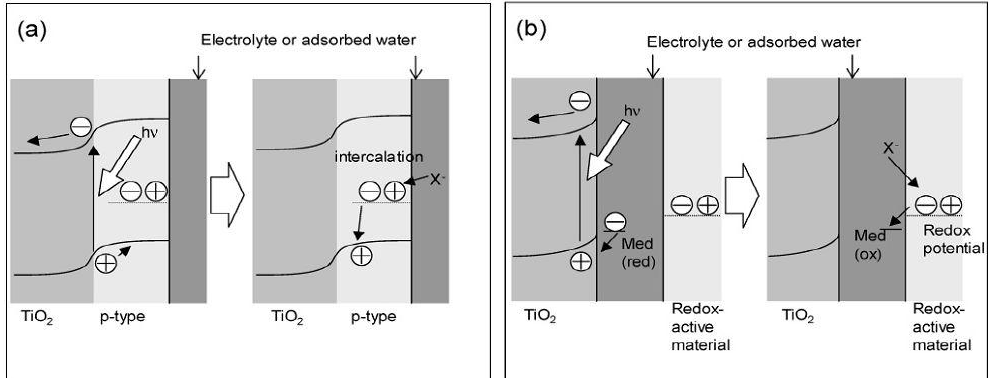
/WO separated films (type a) and TiO /WO 2 3 2 3 /WO composite film 2 3